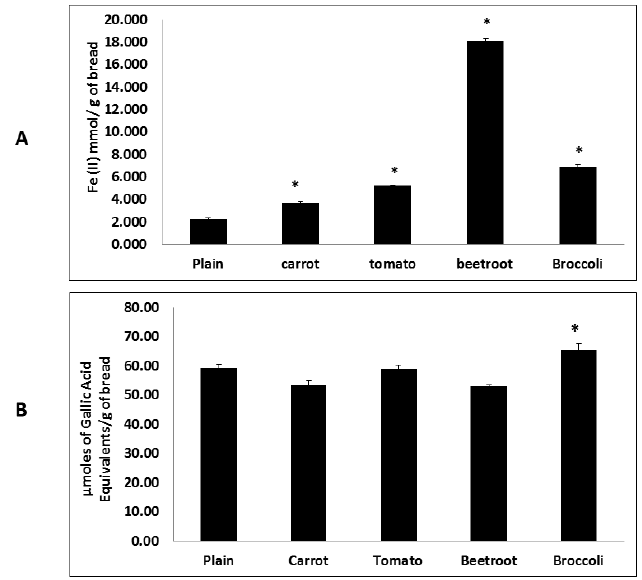
Figure 1. Antioxidant potential of the breads. Antioxidant potential of breads measured using FRAP ( A ) and HORAC ( B ) assays. Treatments with asterisks are significantly different to the plain bread ( p < 0.05). Values are means ± SE ( n = 3).